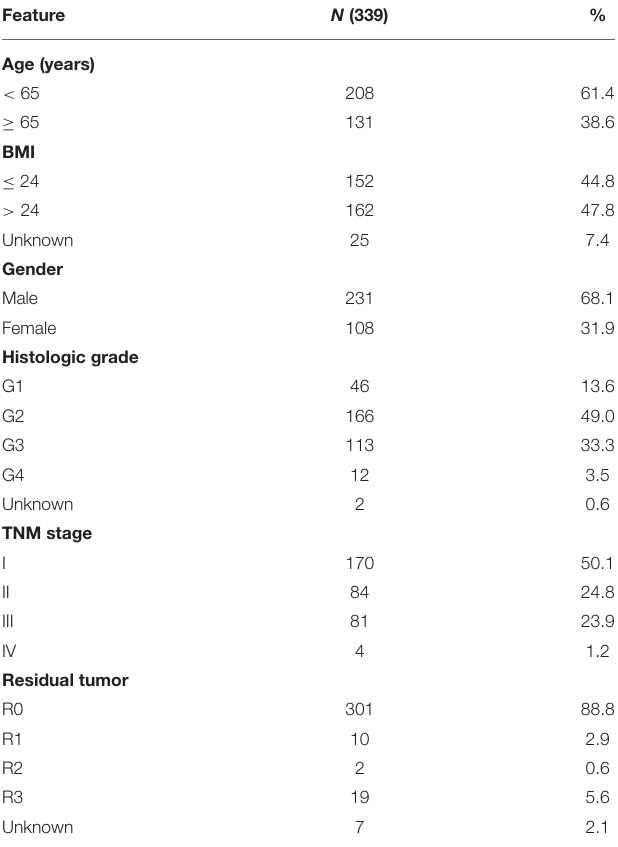
TABLE 1 | Clinical pathological parameters of patients with HCC.